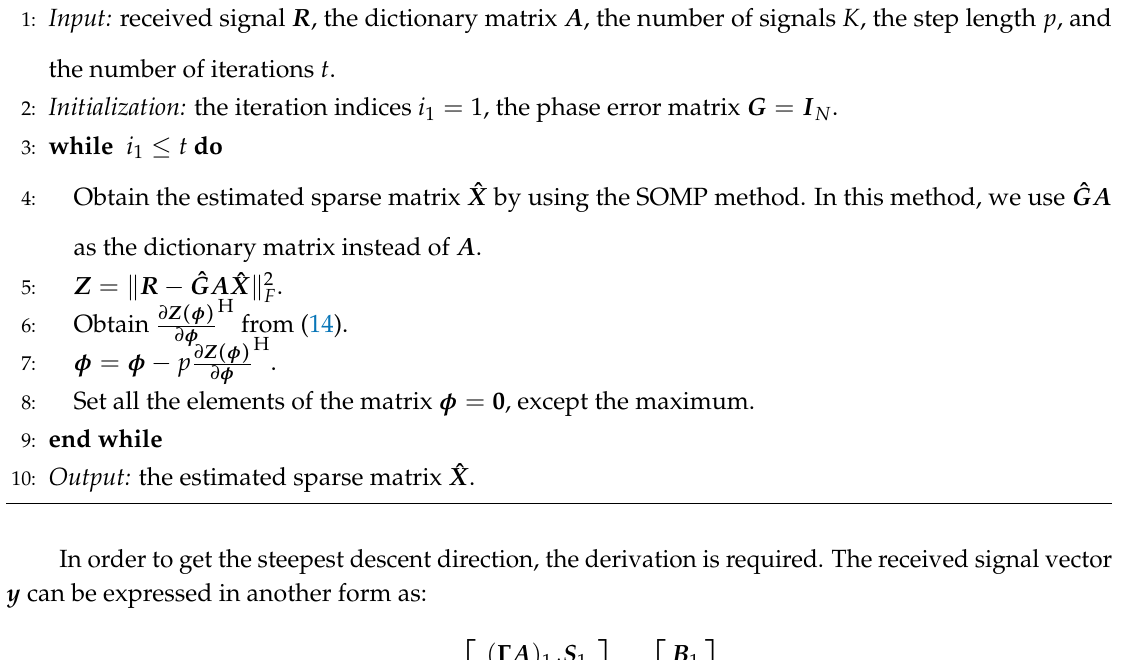
Algorithm 1 The proposed algorithm to estimate the DOAs in the scenario with phase errors among the